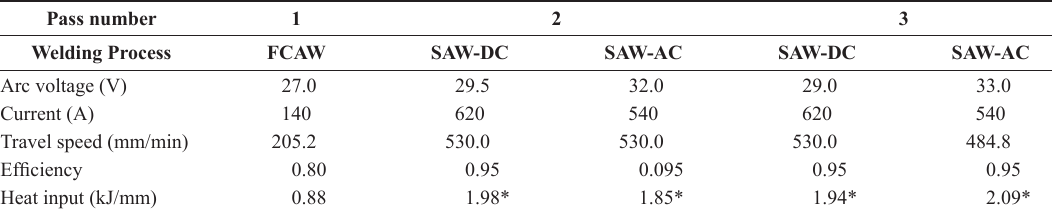
Table 5: Welding parameters for two wires tandem SAW (T-SAW)